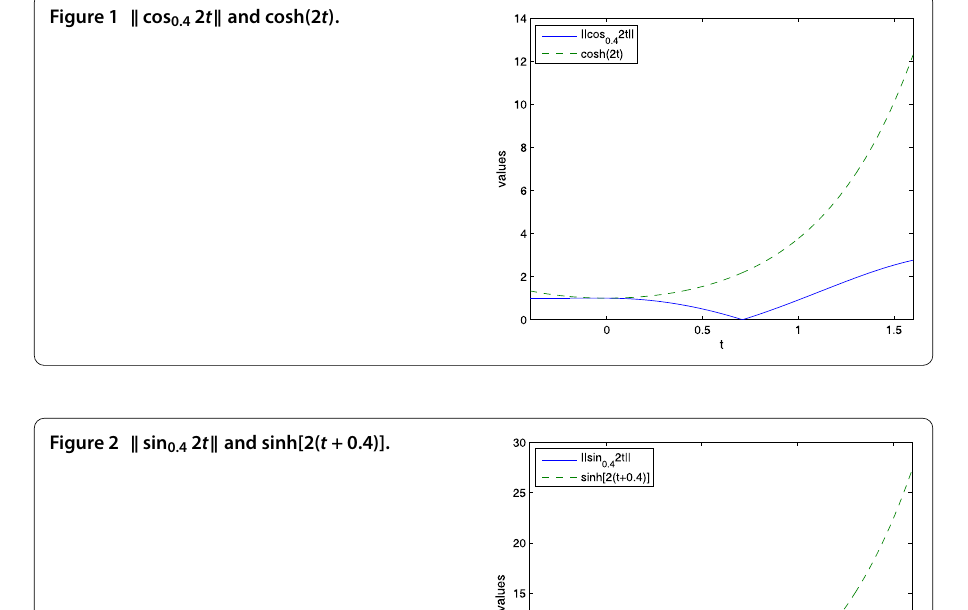
Figure 1 (cid:2) cos 0.4 2 t (cid:2) and cosh(2 t ).